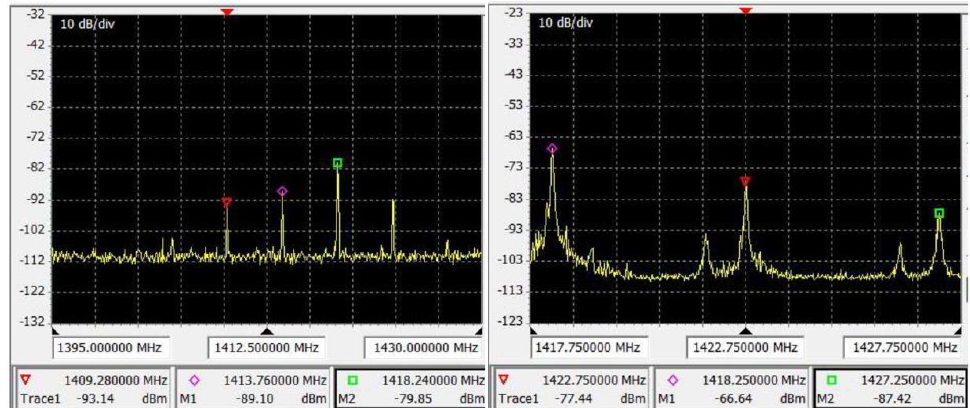
Figure 21. The top image displays the fundamental frequency of the emission within the band 470 − 476 MHz from a TV broadcast relay station. The bottom left image displays the third harmonic of the video signal; the bottom right image displays the third harmonic of the audio signal. Source: Anatel (NRA, Brazil).